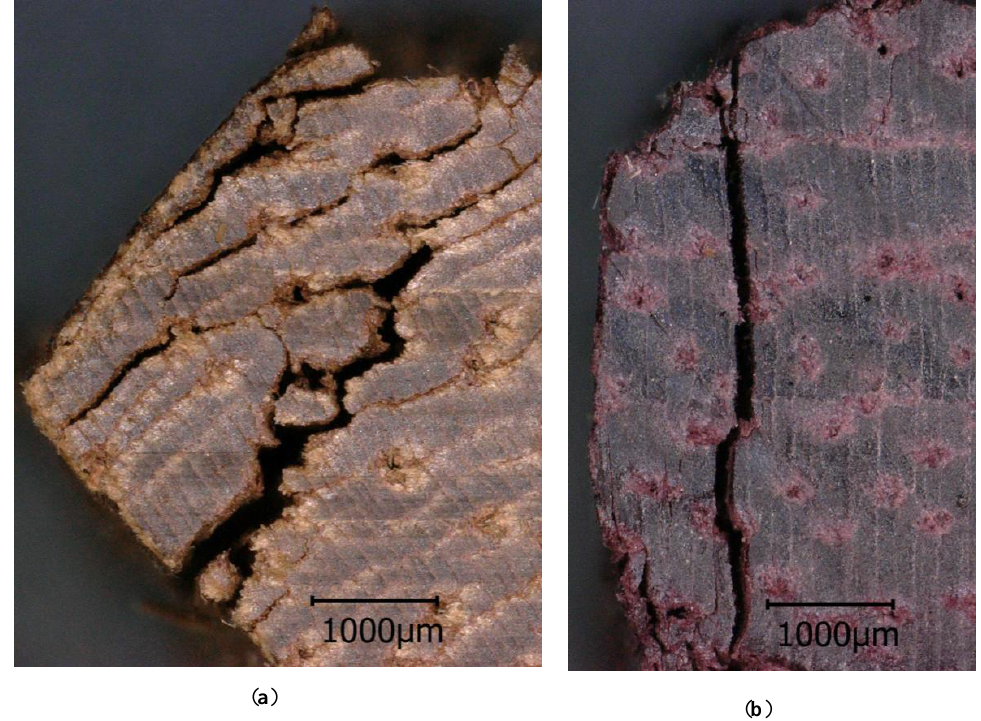
Figure 7. The fracture pattern in the diffuse-porous hardwoods: ( a ) the cross section of the Bongossi, the tangential fractures; ( b ) the cross section of the Amaranth – the radial fractures along the rays. the tangential fractures; ( b ) the cross section of the Amaranth—the radial fractures along the